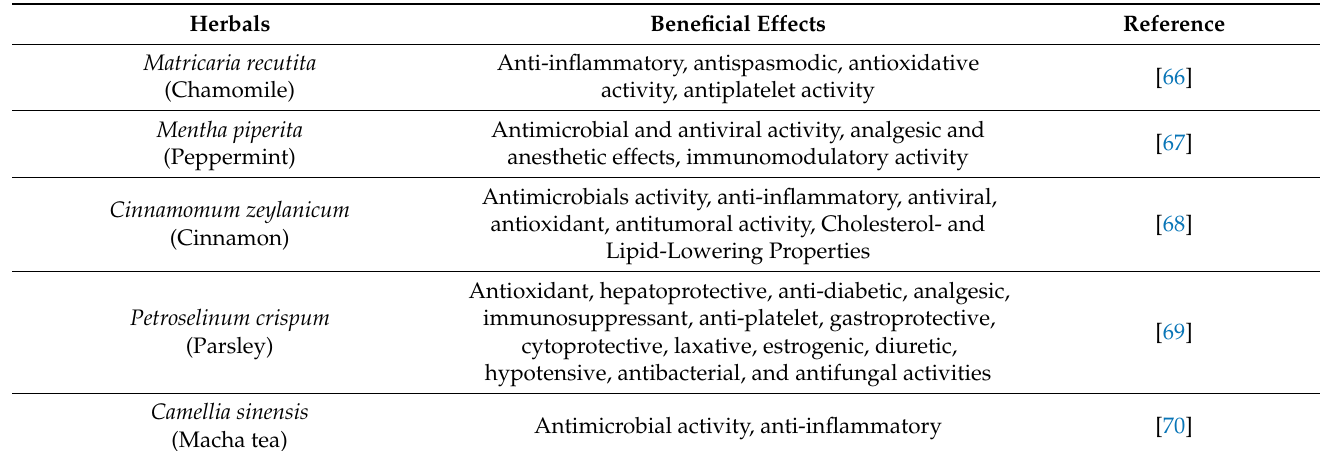
Table 3. Most common herbal teas and health effects.